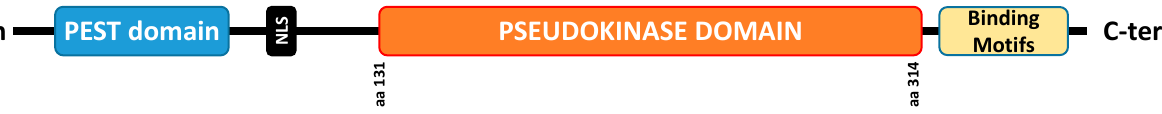
Figure 3. Functional domains of TRIB3 protein. NLS = nuclear localization signal.